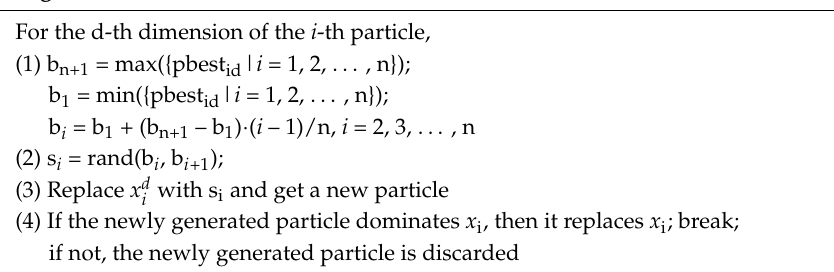
Algorithm 2. The Detailed Procedure of A Personal Guide